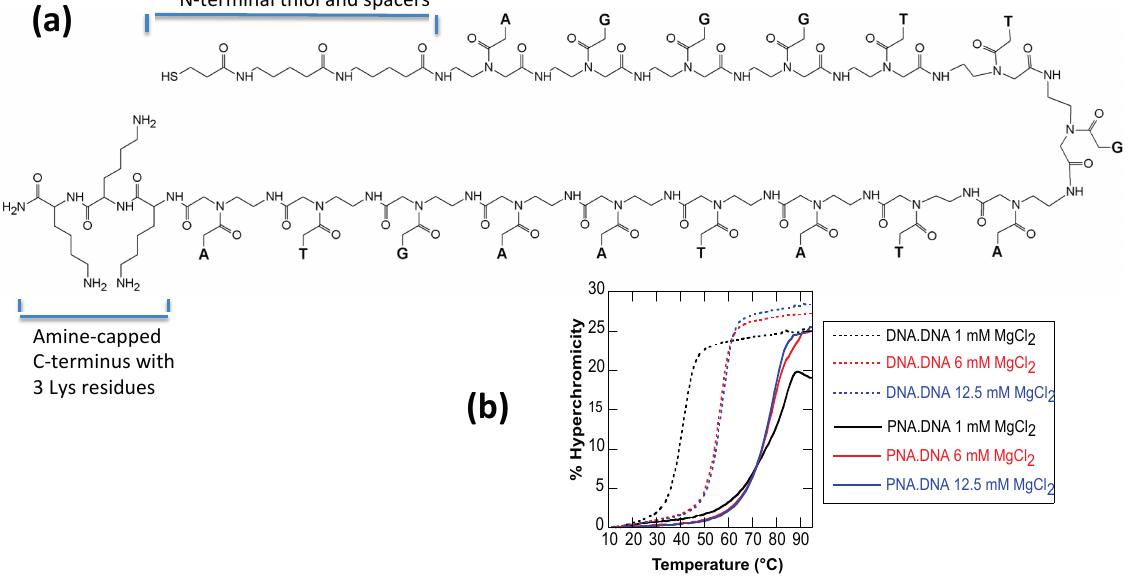
Figure 1. ( a ) Chemical structure of the PNA3K with nucleobases shown as single letters (A, T, G); ( b ) Melting curves of PNA3K·DNA heteroduplex (solid lines) and DNA·DNA homoduplex (dotted lines) at different concentrations of MgCl 2